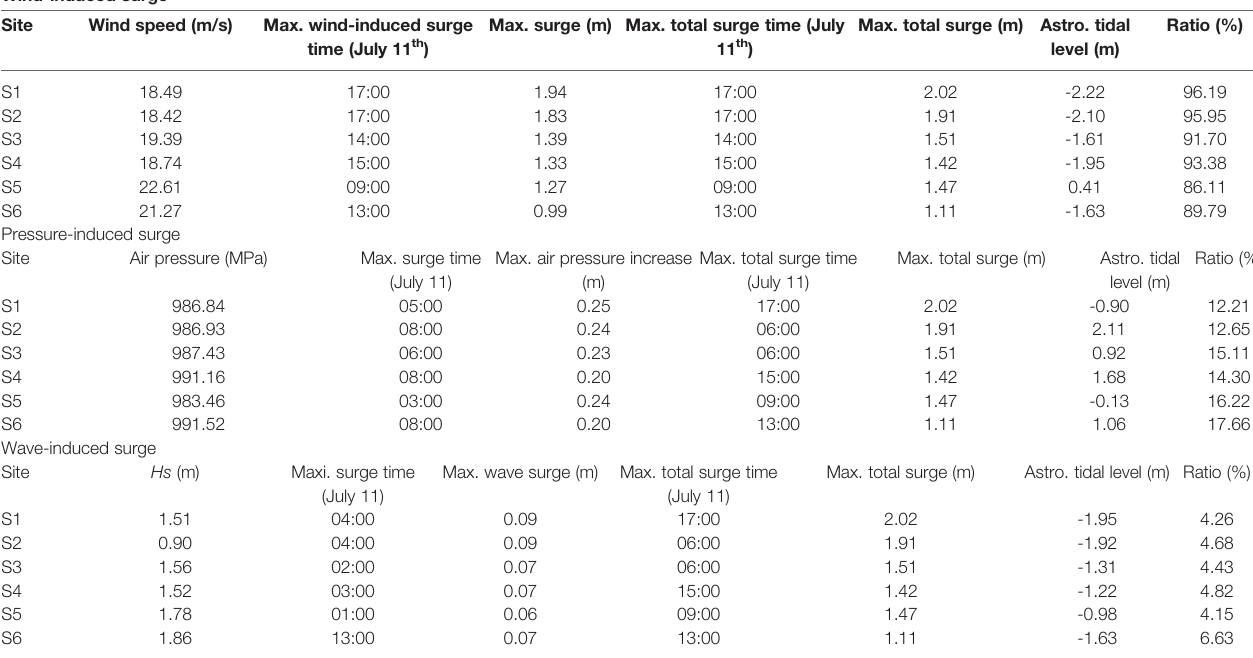
TABLE 6 | Summary of characteristic values of wind-induced surge, pressure-induced surge and wave-induced surge.